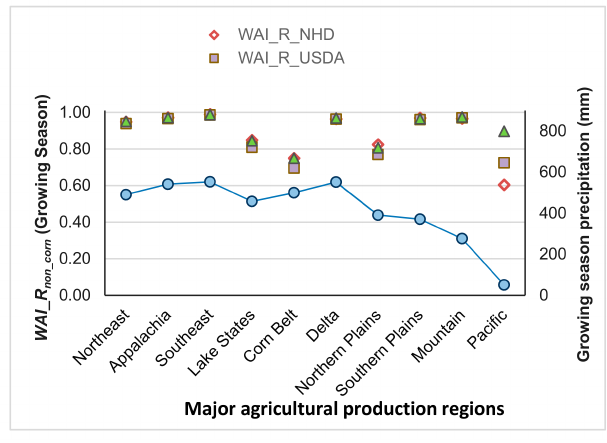
Figure 10. Regional growing-season rainwater available to other plants and uses after meeting corn water demand ( WAI_R non_corn ) based on corn production. WAI_R_NHD, WAI_R_USDA, and WAI_R_Smith refer to WAI_R non_corn based on growing-season ER estimated using NHDPlus V2 data, the USDA-SCS method, and the Smith method,